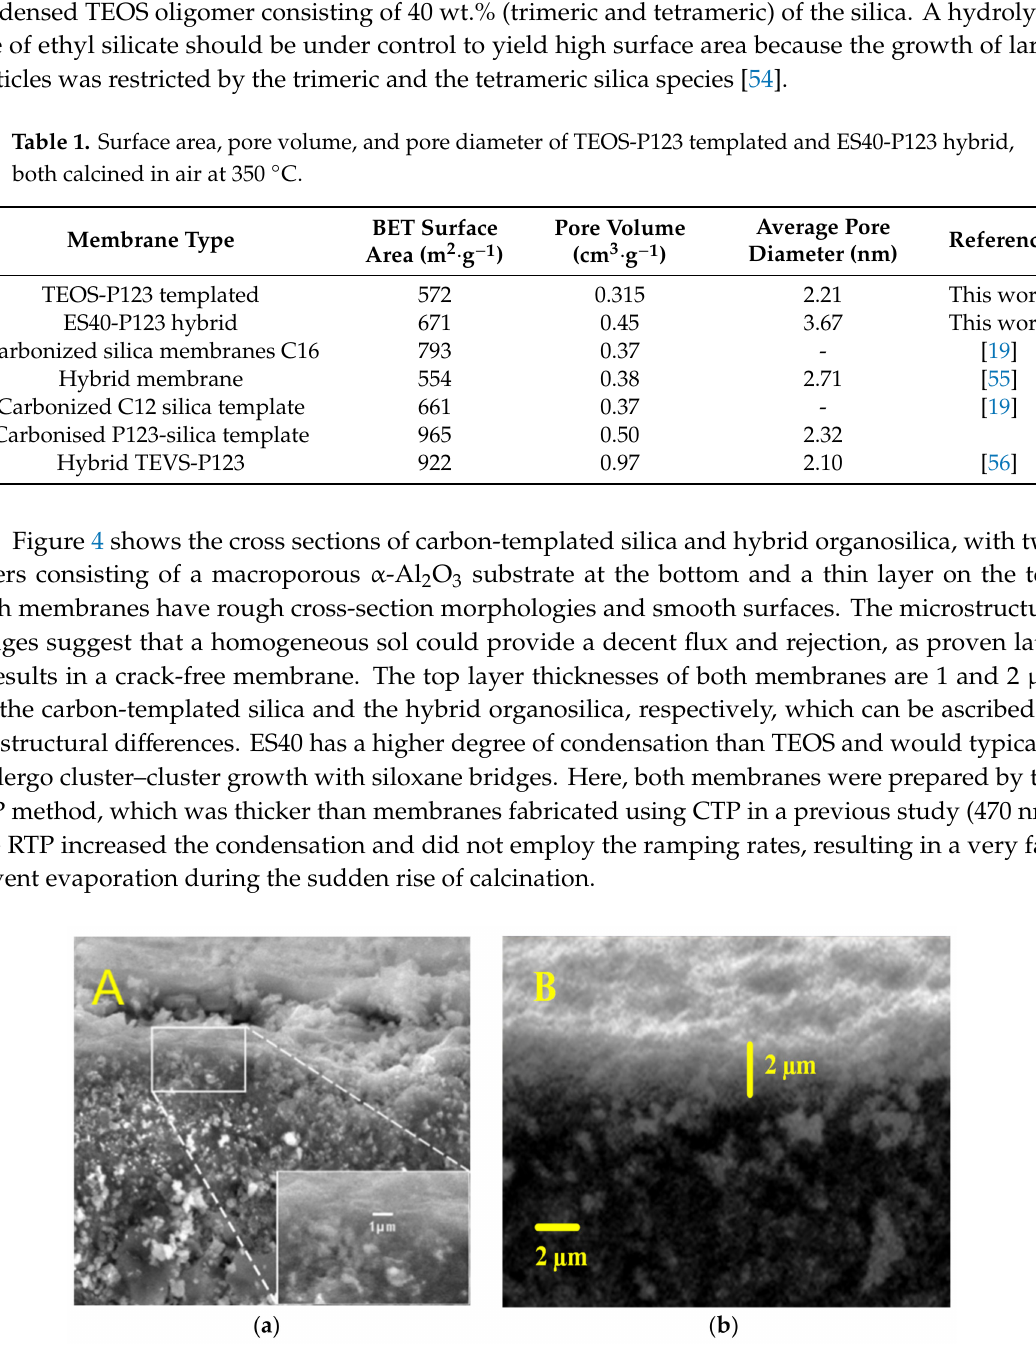
Figure 4. SEM images respective to ( a ) carbon-template silica vs. ( b ) hybrid silica of membranes’